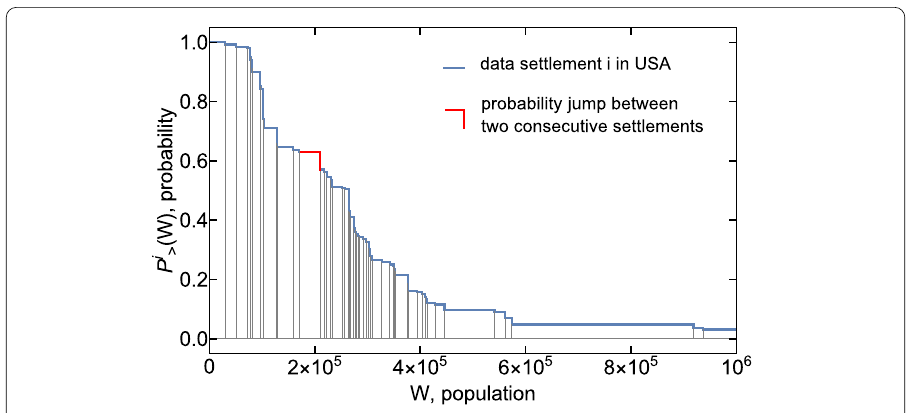
Figure 3 Step-like form of the P i > ( W ) probability for commuters starting from a given city, i . The red marked part shows one probability jump between two consecutive